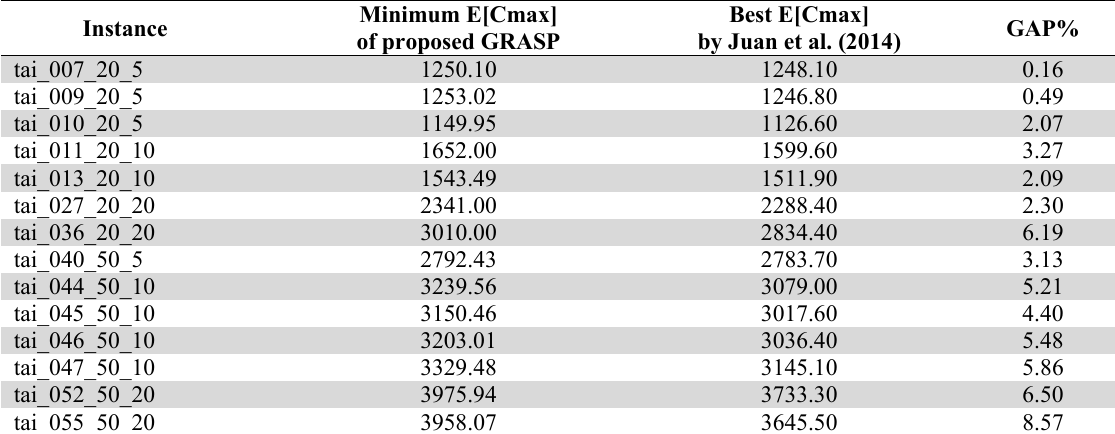
Table 9 GAP for Minimum makespan when (cid:1829)(cid:1848) (cid:3404) (cid:3495)2 (cid:1831)(cid:3427)(cid:1868) Instance